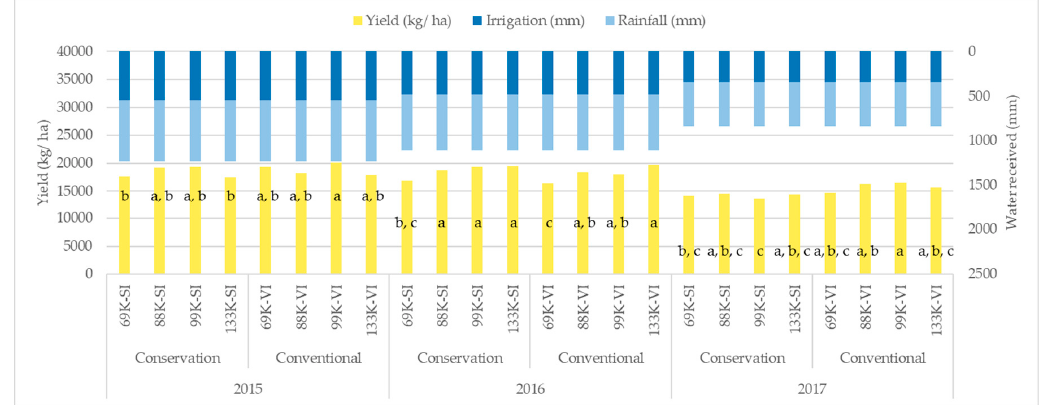
Figure 10. Yield (kg/ha) produced in RDC field by each treatment and the total amount of water (mm) received by each treatment per growing season.